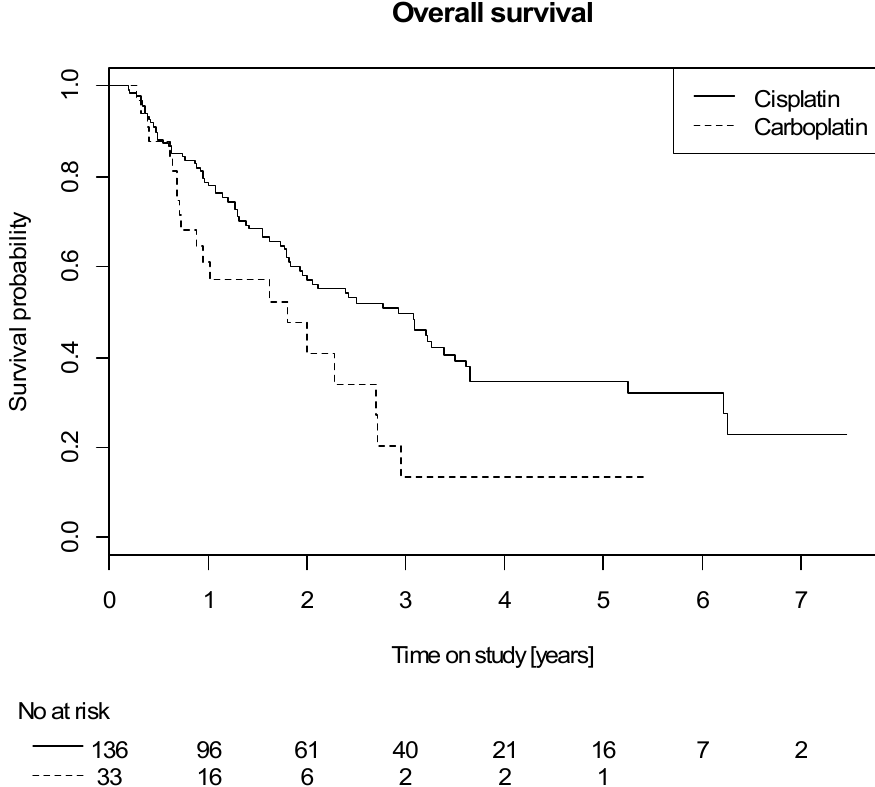
Figure 2. Overall survival of patients with cisplatin vs. carboplatin-based protocols. Table 5. Multivariate analysis of the impact of cisplatin vs. carboplatin together with known selection parameters and completeness of chemotherapy on overall survival.